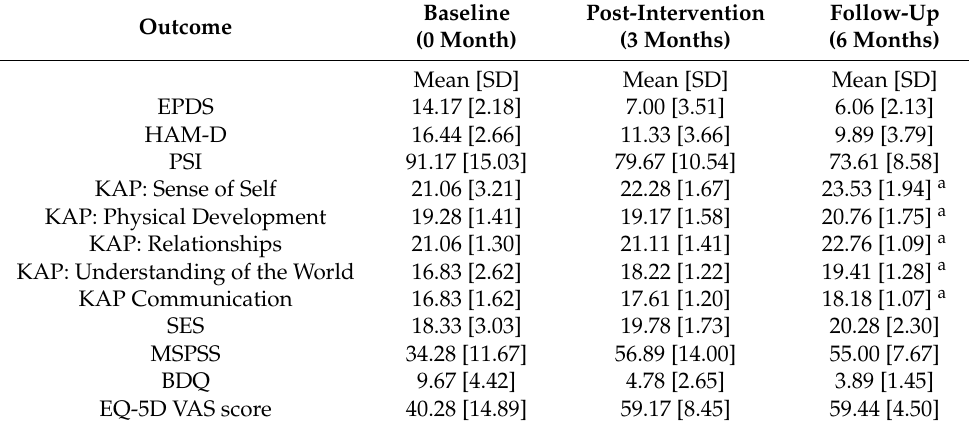
Table 2. Father depressive symptomatology, parenting-related outcomes, resilience outcomes, and physical functioning pre- and post-intervention and at follow-up ( N =